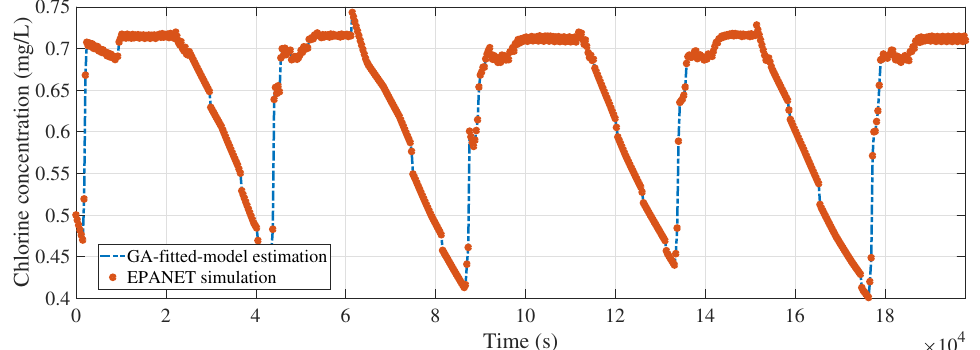
Figure 6. Calibrated model fitting for node 5 (rmse = 2.0835 × 10 − 4 mg/L).